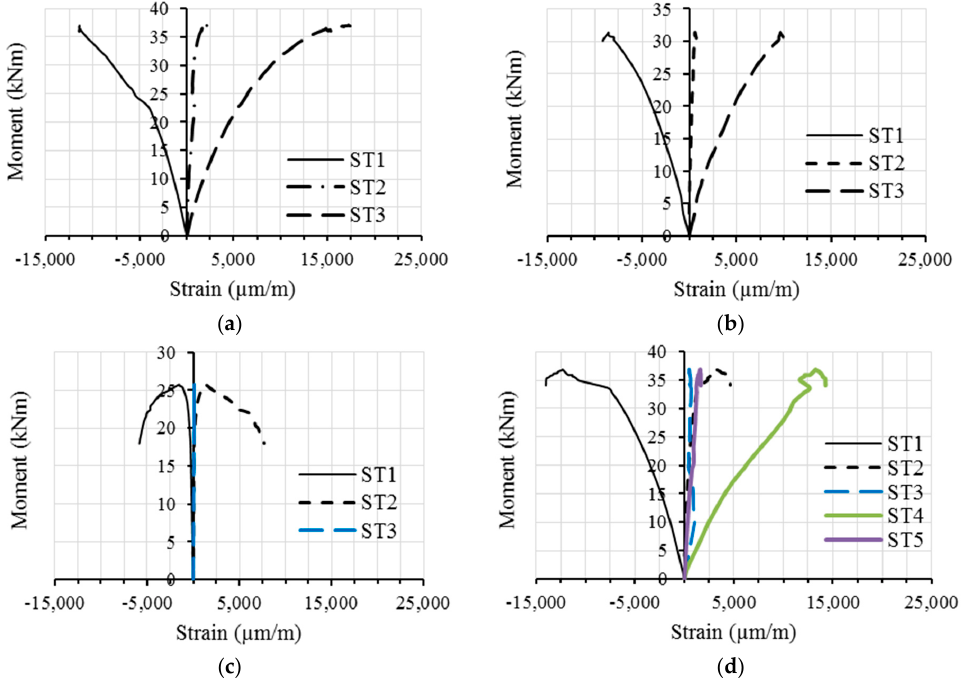
Figure 9. Typical moment–strain relationships. ( a ) MC0; ( b ) MC100; ( c ) MC100-N; and ( d ) MC100-N-3CFRP.